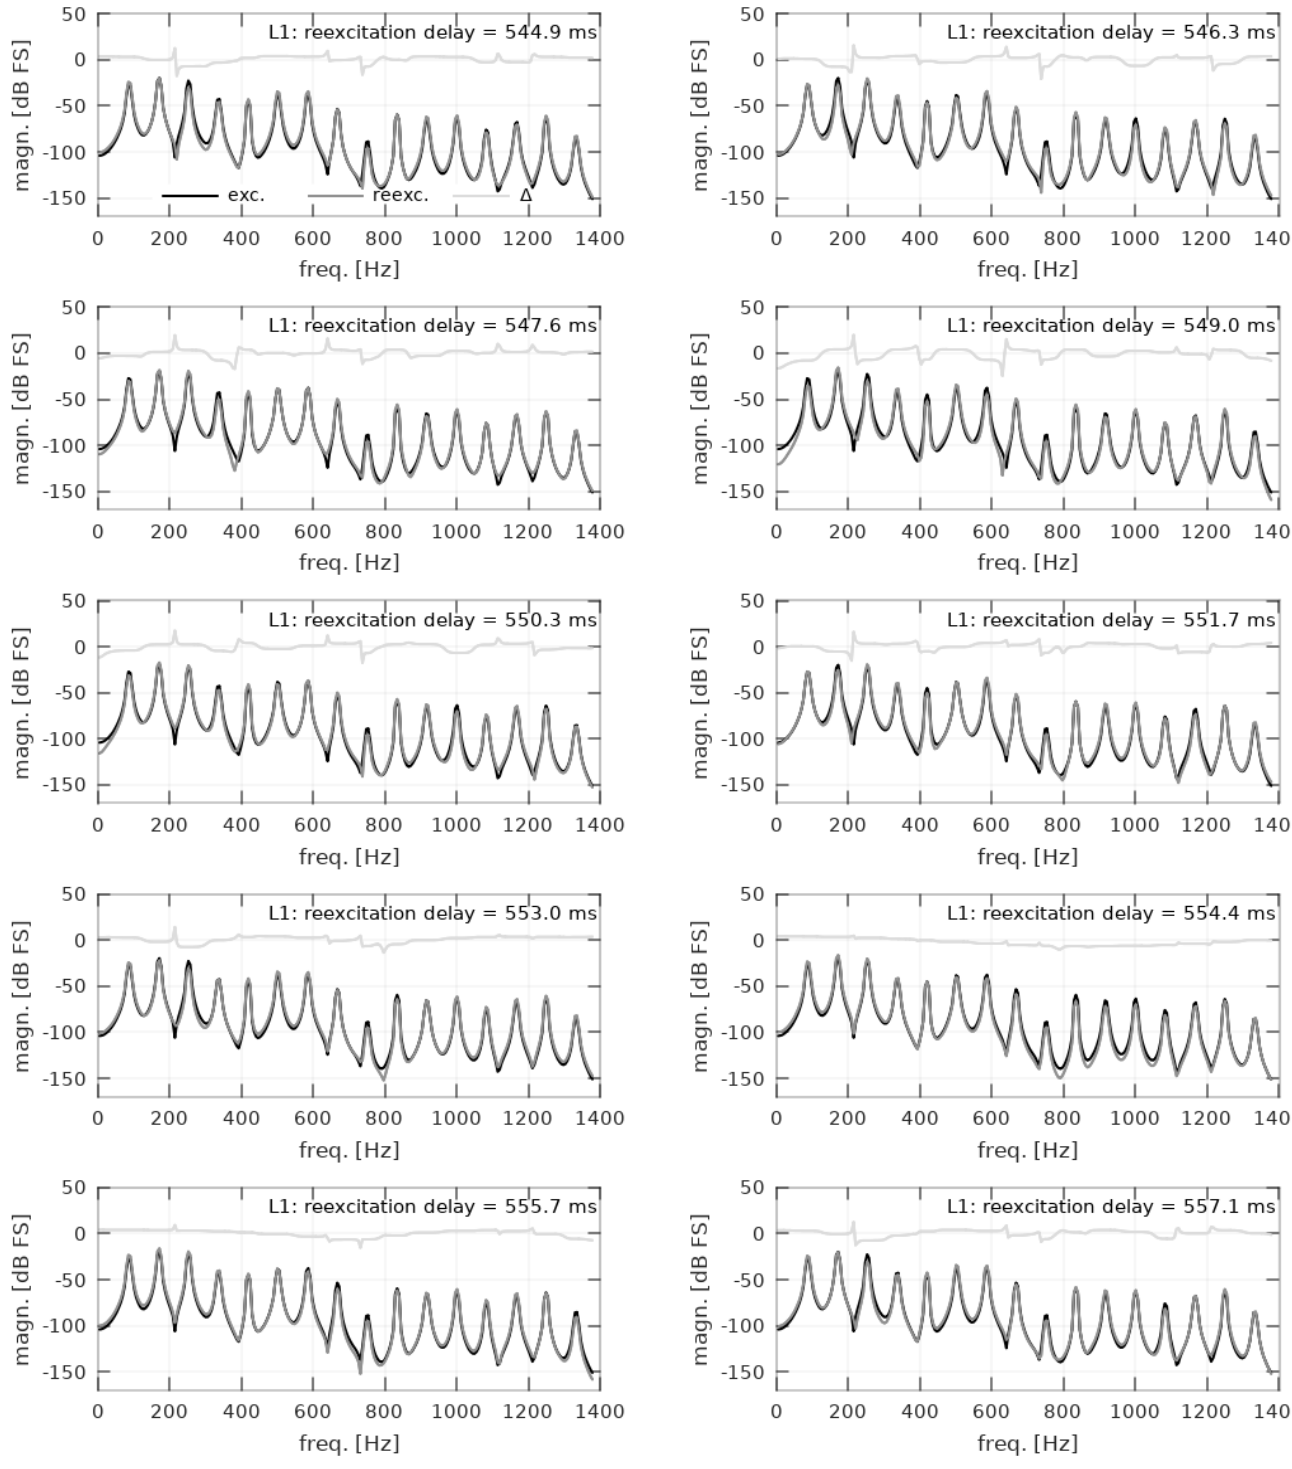
Figure 8. Simulation L1—spectra of primary excitation (dark plot) and re-excitation (medium) for all simulated delays; ∆ (light) represents spectral